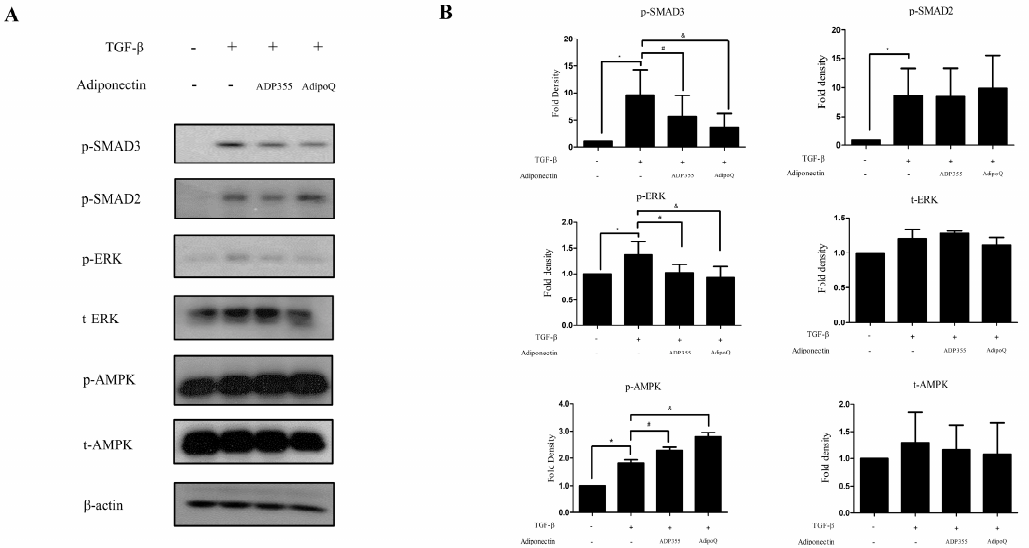
Figure 3. E ff ect of ADP355 on the TGF- β 1-induced downstream pathways. TGF- β 1-induced increases in phosphorylation of SMAD2, SMAD3, ERK, and AMPK. Treatment with ADP355 (10 µ g / mL) and adiponectin recombinant, AdipoQ (10 µ g / mL), reversed TGF- β 1-induced phosphorylation of SMAD3 and ERK and accentuated phosphorylation of AMPK. ( A ) Western blot analysis results. ( B ) Quantification of western blot results (* p ≤ 0.05, control vs. TGF- β , # p ≤ 0.05, TGF- β vs. TGF- β + ADP355, and & p ≤ 0.05, TGF- β vs. TGF- β + AdipoQ). The data are expressed as mean ± SD. Representative data are shown from three independent experiments.